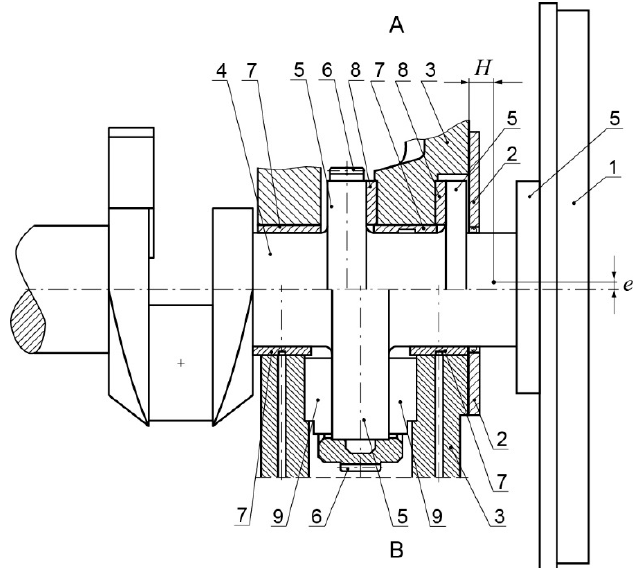
Figure 19. The flywheel end of the crankshaft of engine with locating bearing (part A) and thrust bearing (part B): 1—flywheel, 2—engine cover with sealing, 3—engine body, 4—main journal of shaft, 5—flange of crankshaft, 6—gear wheel for camshaft drive, 7—main bearing shell, 8—thrusting half, 9—thrust pads, H—distance between the face plane of machine body and a point on the crankshaft axis in the measuring plane, e —distance between shaft axis and axis of holes in the machine body.